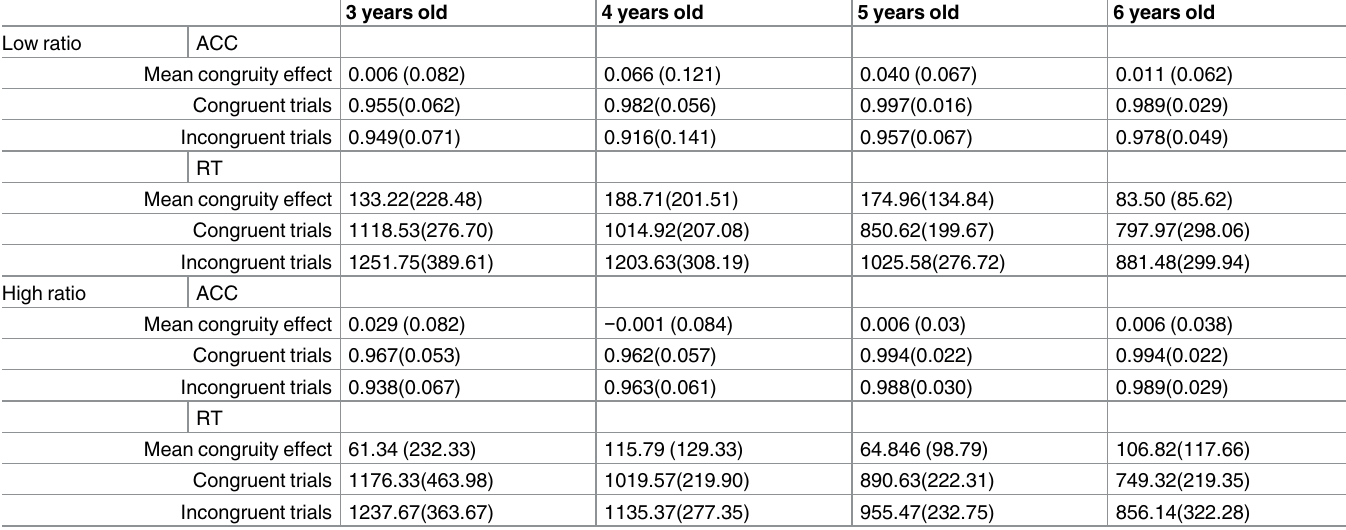
Table 2. Mean accuracyand reaction times (standard deviation) under each